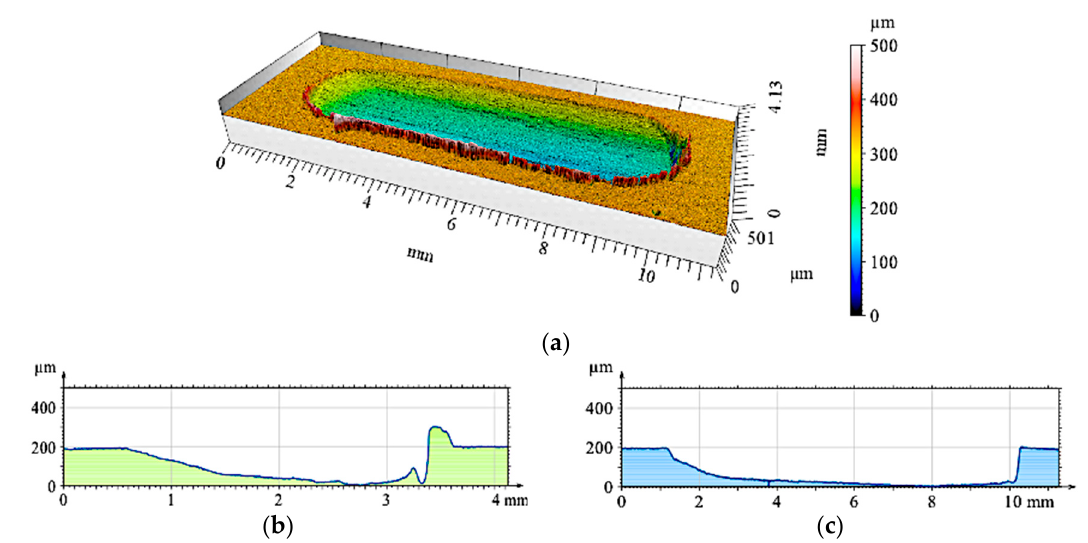
Figure 17. The surface geometry of the single composite layer (S10) after working with a cast iron pin: ( a ) View of the wear track; ( b ) Roughness distribution across the friction direction; ( c ) Roughness distribution along the friction direction.